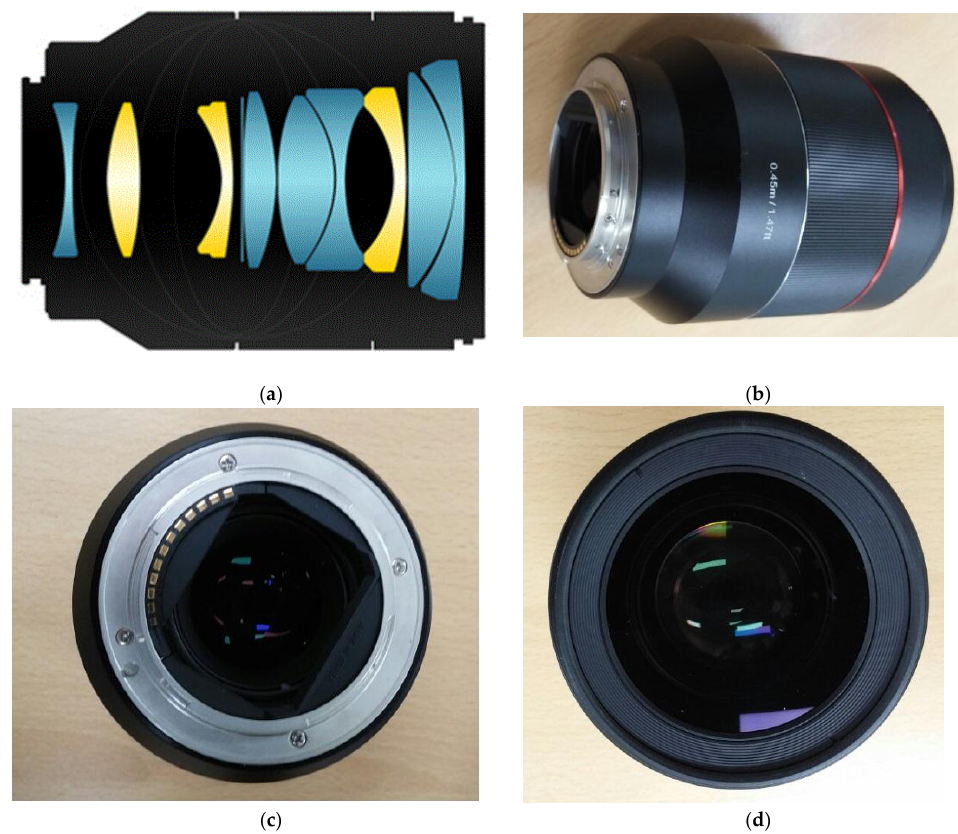
Figure 4. ( a ) Interior and ( b ) exterior images of our fabricated double-Gauss lens; ( c ) top and ( d ) bottom view image of our manufactured double-Gauss